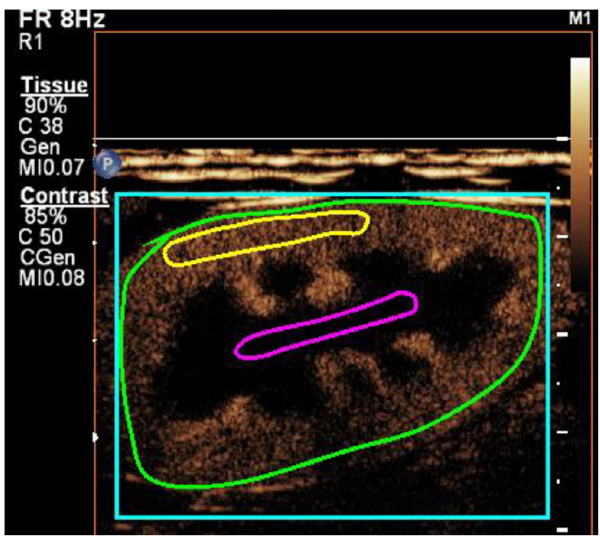
Fig 2. A contrast-enhanced ultrasound image of a left kidney in the sagittal plane of dog with region-of-interests drawn in the renal cortex (yellow line), renal medulla (magenta line) and on the entire kidney (green line). The size of region-of-interests, from which time-intensity curves were generated, were 0.51 cm 2 for the cortex and 0.37 cm 2 for the